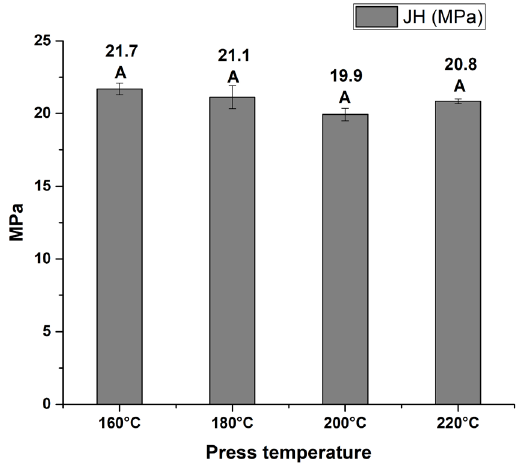
Figure 8. Janka hardness (JH) for particleboard panels produced with sugarcane bagasse and plastic bag particles at different pressing temperatures. * Averages followed by similar letter did not differ statistically by the Scott-Knott test at 5% significance level.